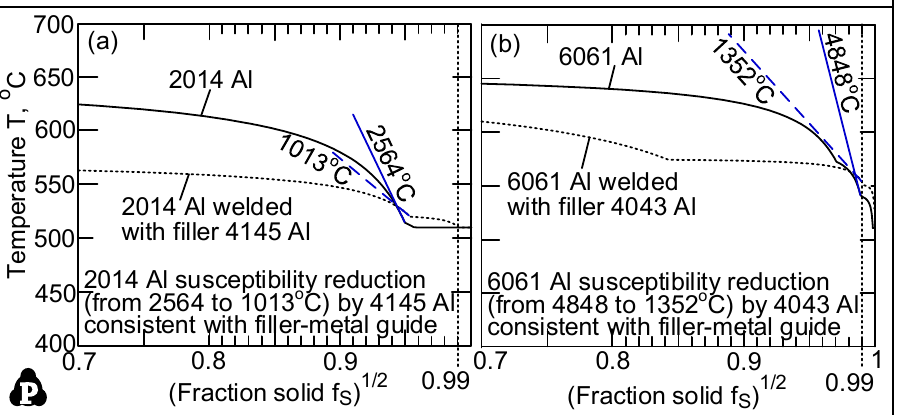
Figure 8. Reduction of susceptibility to solidification cracking by selecting proper filler metals: ( a ) 2014 Al welded with filler metal 4145 Al; ( b ) 6061 Al welded with filler metal 4043 Al. Predictions are consistent with filler-metal guides data from [37,38].